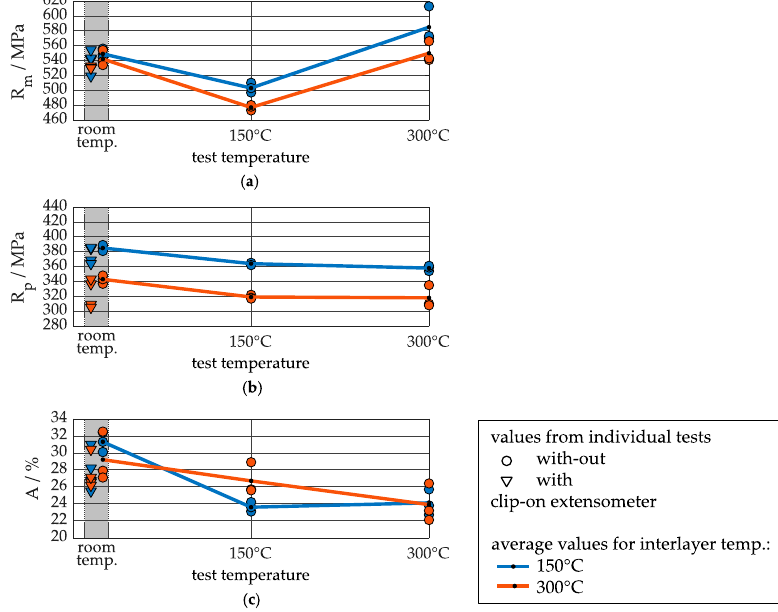
Figure 9. Average tensile properties for different test temperatures: ( a ) tensile strength, ( b ) yield strength, ( c ) elongation at rupture.